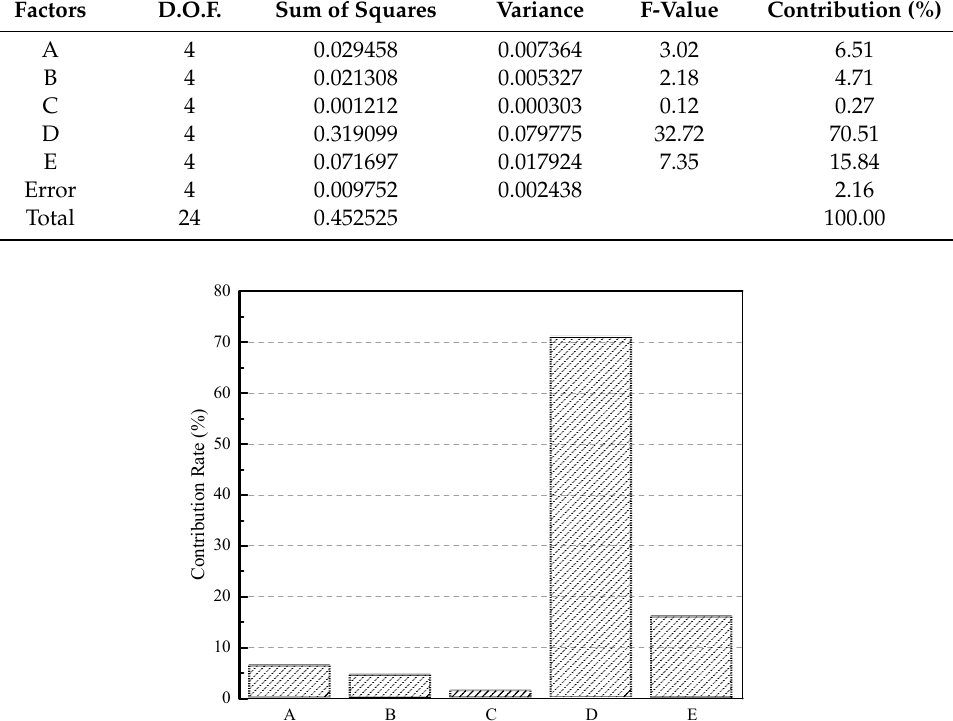
Figure 19. Contributions of each factor to the grey relational grade.